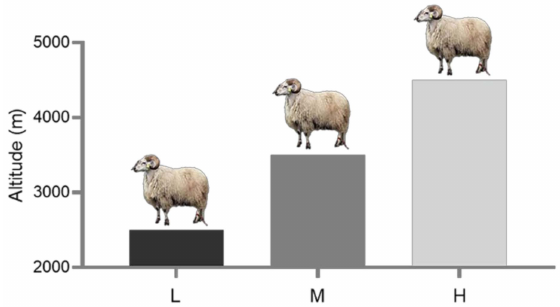
Figure 1. Altitude distribution of Tibetan sheep: low (L) altitude = 2500 m; middle (M) altitude = 3500 m; and high (H) altitude = 4500 m. The 2500 m groups were from Zhuoni County, Gannan Tibetan Autonomous Prefecture, China; the 3500 m groups were from Haiyan County, Haibei Tibetan Autonomous Prefecture, China; and the 4500 m groups were from Zhidoi County, Yushu Tibetan Autonomous Prefecture,